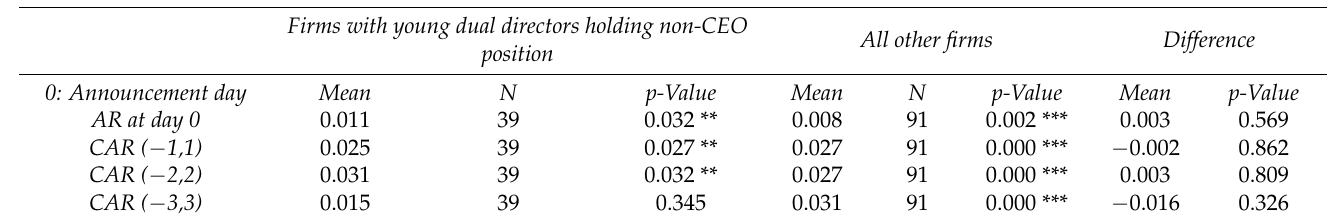
Table 4. Cont. Panel F: Classified by Non-CEO positions &